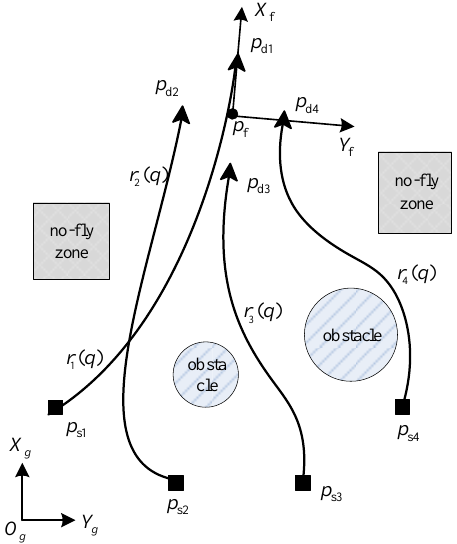
Figure 1. Cooperative path-planning for unmanned aerial vehicle (UAV) formation rendezvous.